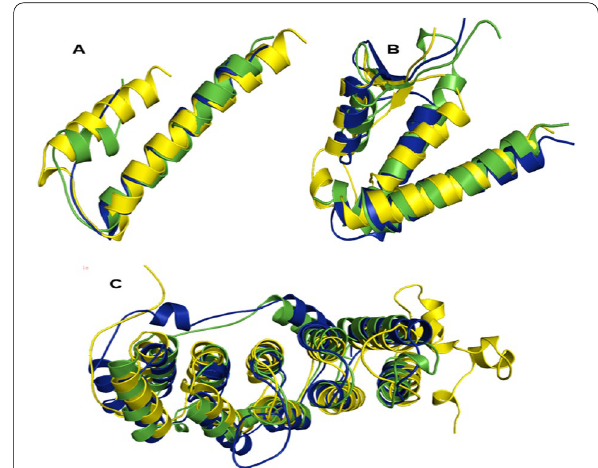
Fig. 2 Alignment of the CENP-HIK subunits from fungi, yeast and the human models. A structural alignment of the hs CENP-H CT , th CENP-H CT and sc CENP-H CT , colored in yellow, green and blue, respectively. B and C also show the structural alignment of CENP-K CT and CENP-I from the three organisms, colored in yellow, green and blue, respectively. The alignment shows a high degree of structural similarity between the